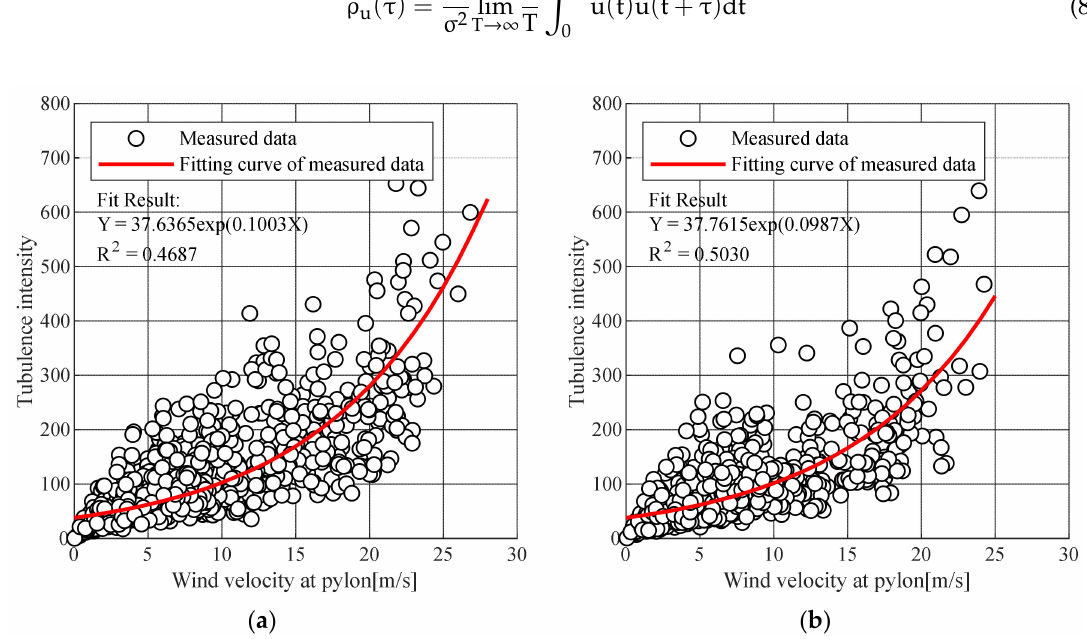
Figure 4. Turbulence length: ( a ) At pylon; ( b ) At